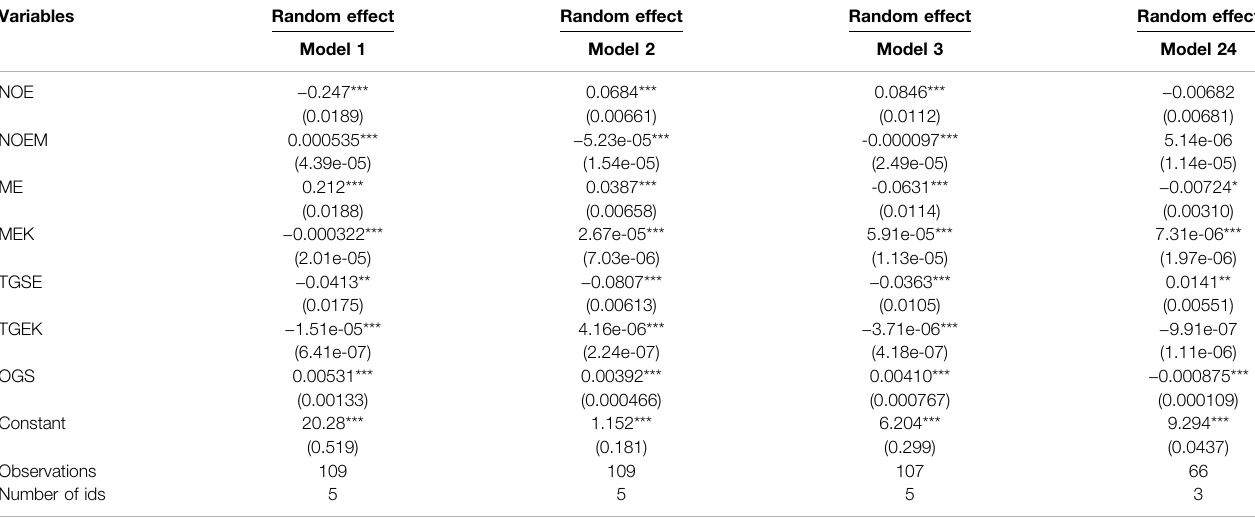
TABLE 5 | Climate extreme and agriculture dynamics under random effect